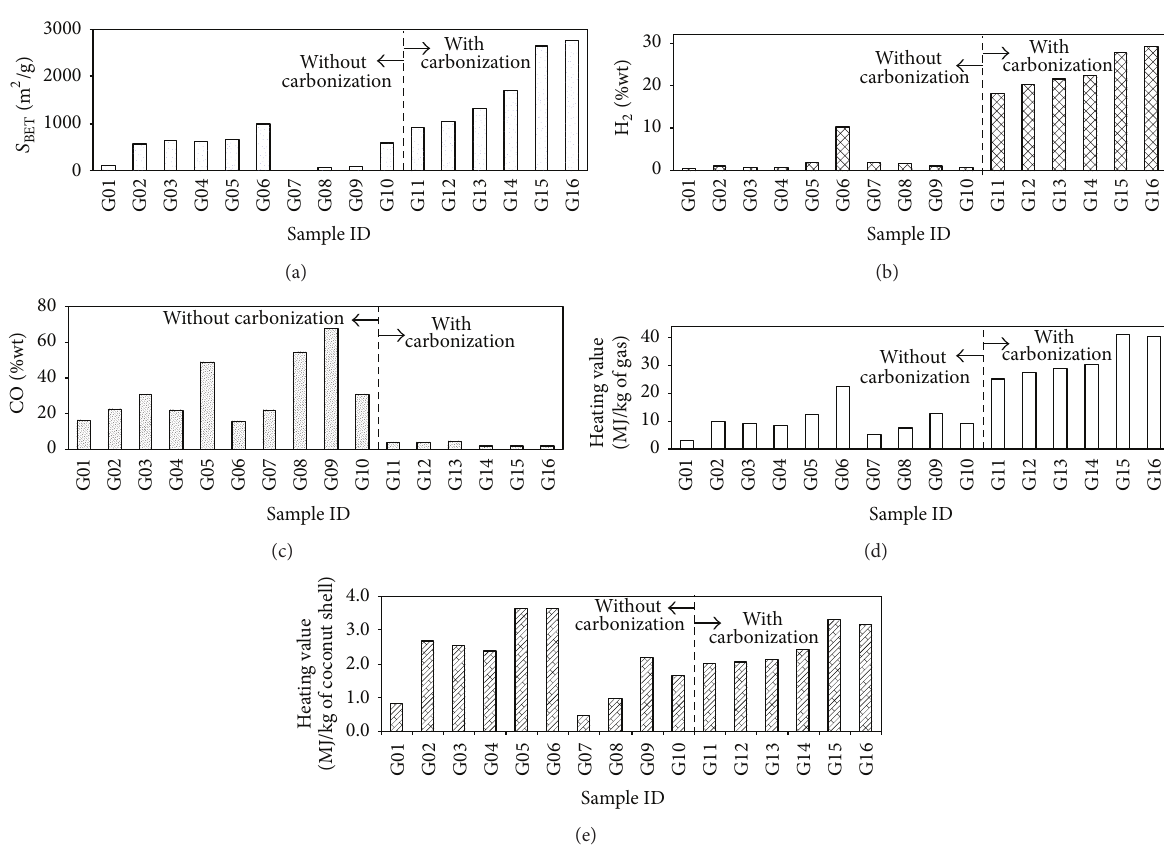
Figure 12: Effect of gasification conditions on (a) specific surface area, (b) hydrogen gas yield, (c) carbon monoxide gas yield, (d) heating value of gas, and (e) heating value of gas base on weight of coconut shell